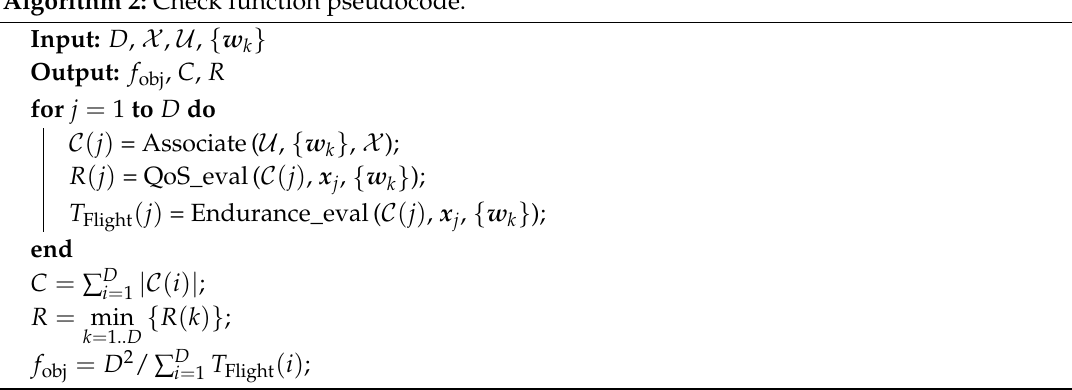
Algorithm 2: Check function